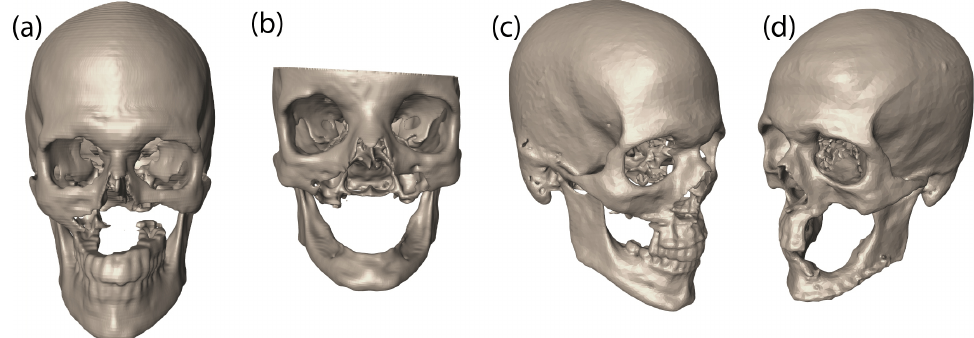
Figure 4. The segmented Digital Imaging and Communications in Medicine (DICOM) data with an isotropic spatial resolution of the four clinical cases used in this study are shown. The DICOM data have a total of 512 images on the frontal and sagittal planes. The number of images on the horizontal plane varies depending on each case. ( a ) Case 1: Bilateral subtotal maxillectomy. ( b ) Case 2: Bilateral subtotal maxillectomy II. ( c ) Case 3: Right limited maxillectomy. ( d ) Case 4: Left limited maxillectomy and mandibular defect in left lateral